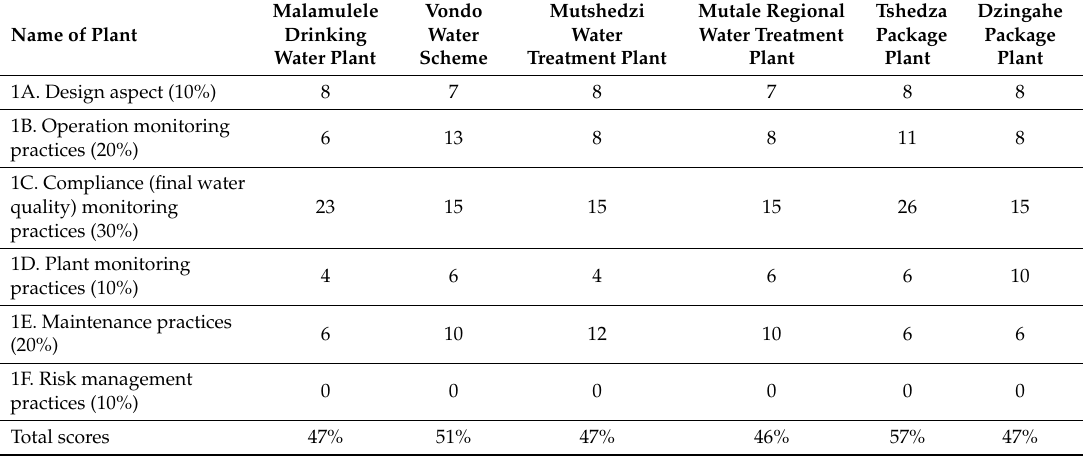
Table 9. Technical assessment: first assessment: period between August 2008 and June